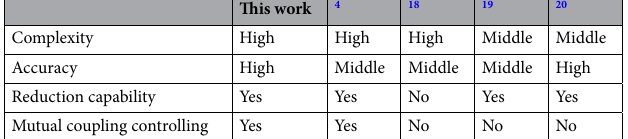
Table 2. The performance comparison of the proposed and other